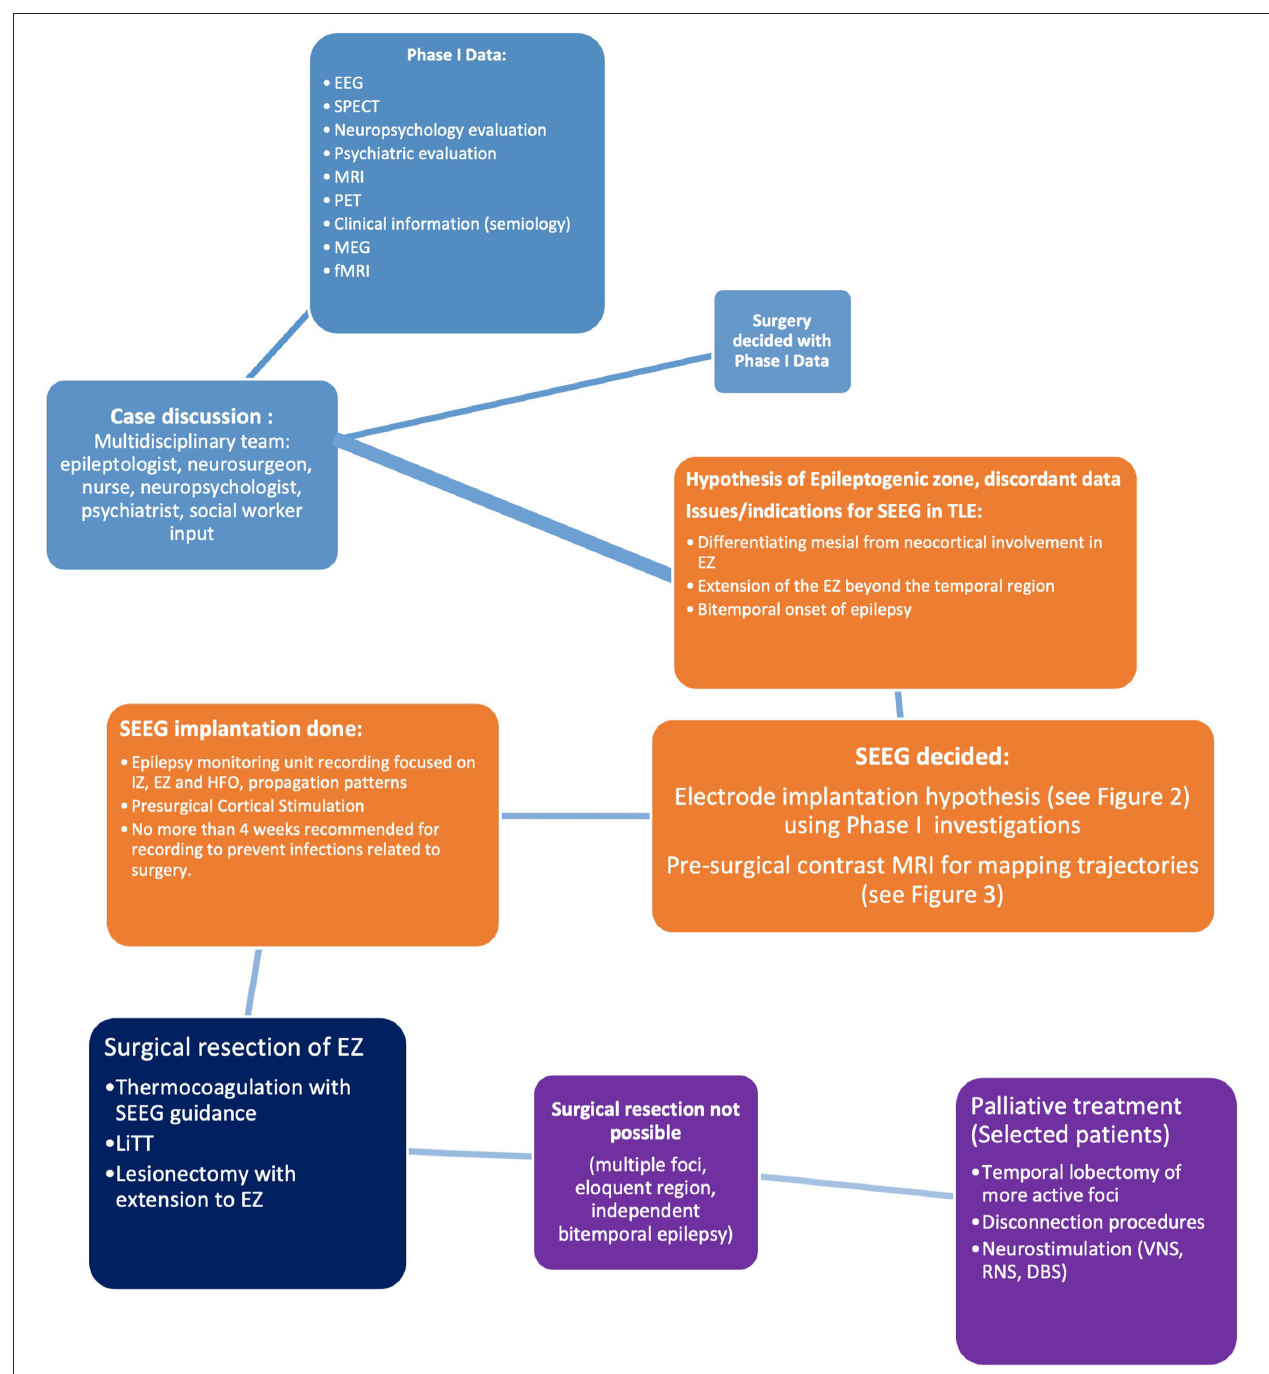
FIGURE 4 | Proposed algorithm for temporal lobe epilepsy investigations using SEEG.